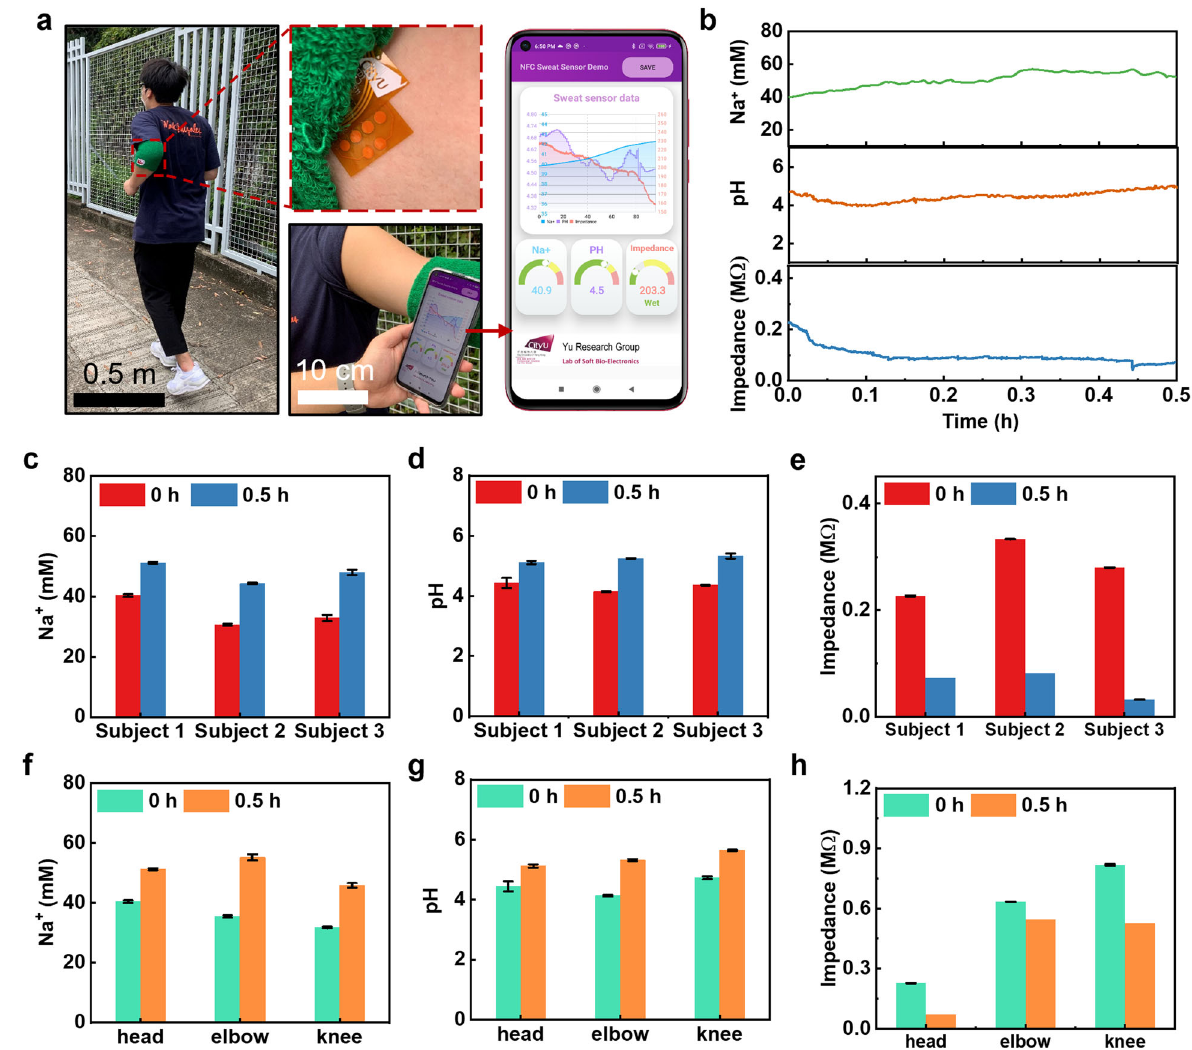
Fig. 4 On-body real-time health monitoring and wireless data transmission. a Optical images of the jogging subject wearing SMS embedded in the elbow pad and the phone interface that illustrates wireless communication and data acquisition. b The real-time monitoring results of the sweat Na + concentration, pH value and skin impedance during jogging. c – e The comparison of data changes of Na + concentration, pH value, and skin impedance during exercise on heads of three different subjects. f – h The comparison of data changes of Na + concentration, pH value, and skin impedance during exercise for three different body locations, including head, elbow, and